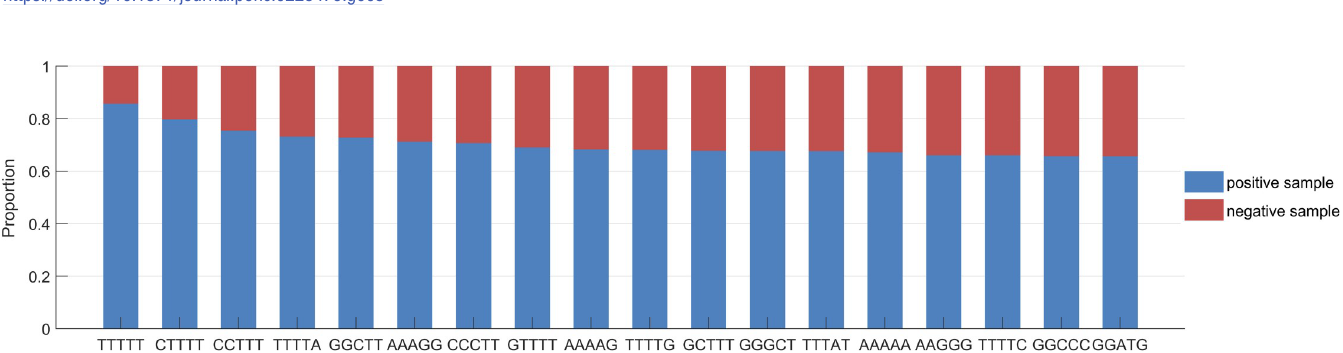
Fig 8. Heat map of each feature score. This figure shows the score of 2600 features we got using F-score.